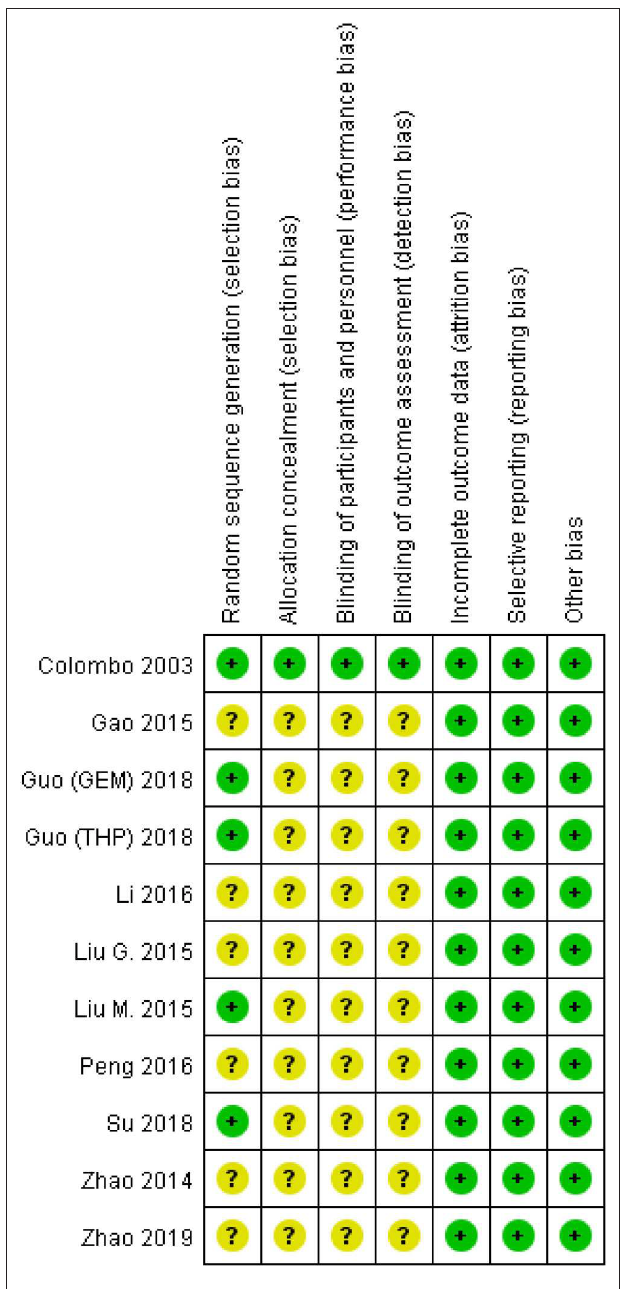
FIGURE 2 | Risk of bias assessment of included studies.